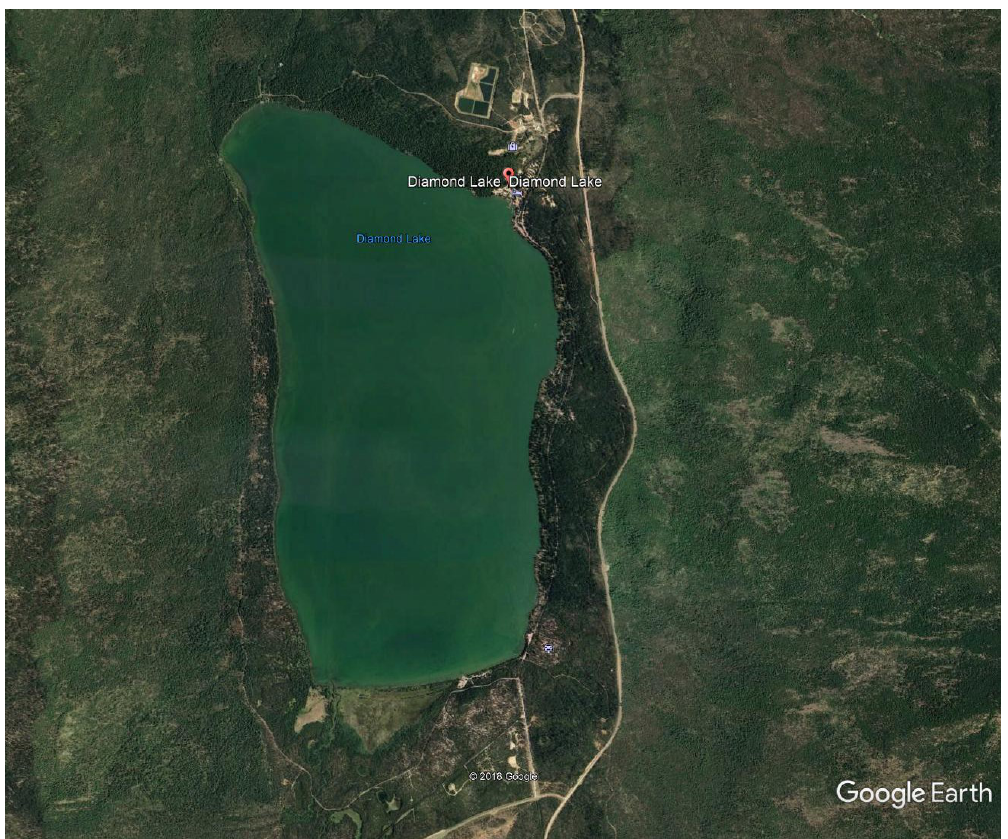
Figure 4. Satellite image of Diamond Lake, Oregon. Image taken 6 July 2014. Source: Image obtained from Google Earth. Water 2019 , 11 , x FOR PEER REVIEW